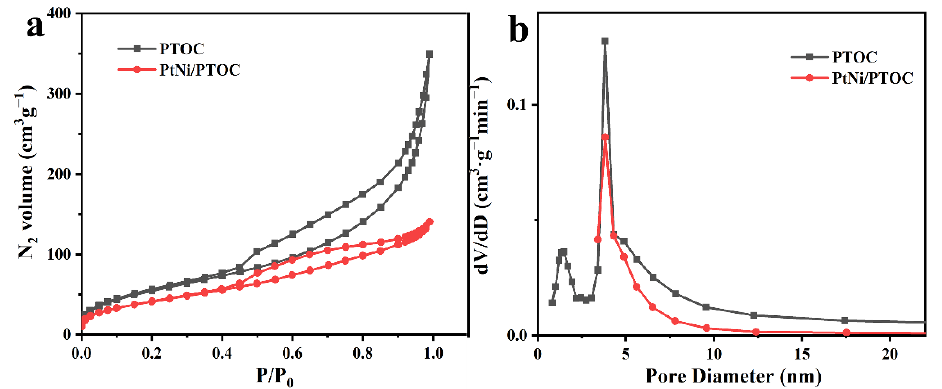
Figure 6. N 2 desorption/adsorption isotherm ( a ) and pore-size distributions ( b ) for PTOC and PtNi/PTOC.